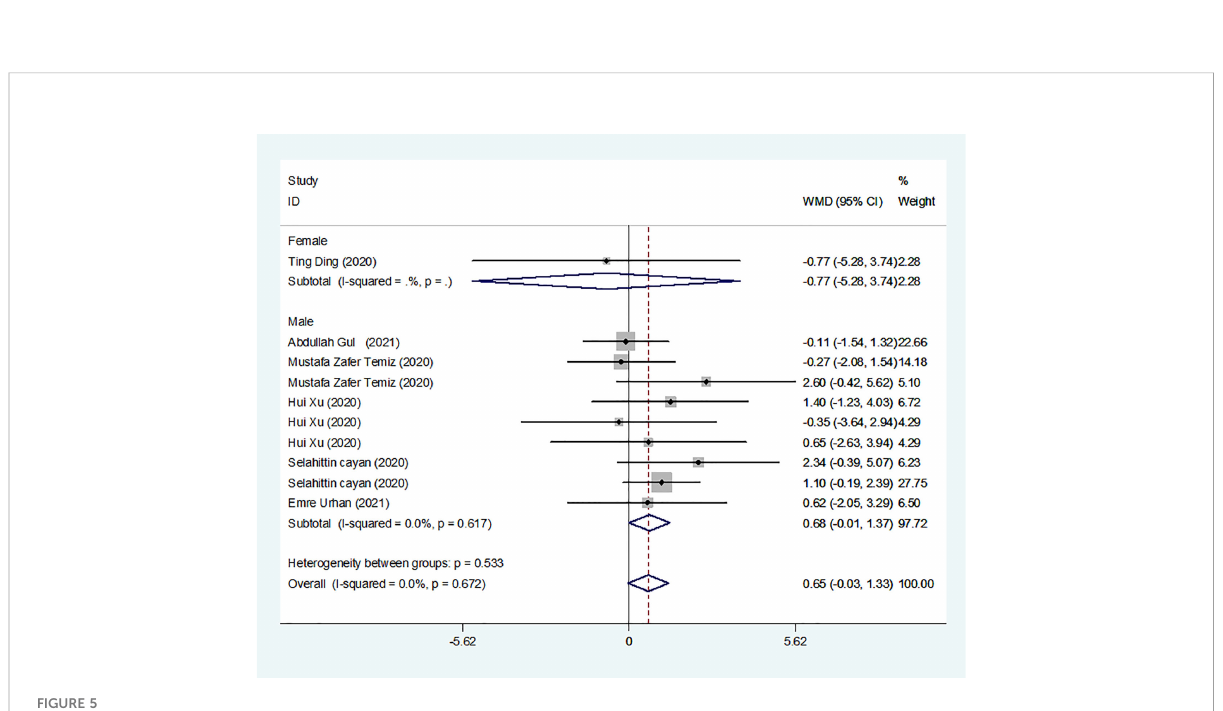
FIGURE 5 PRL levels in people with COVID-19 versus those without